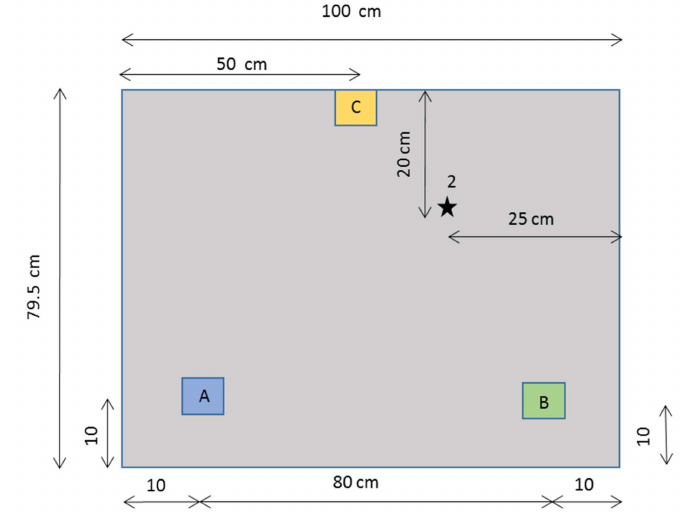
Figure 11. Scheme for Case Study